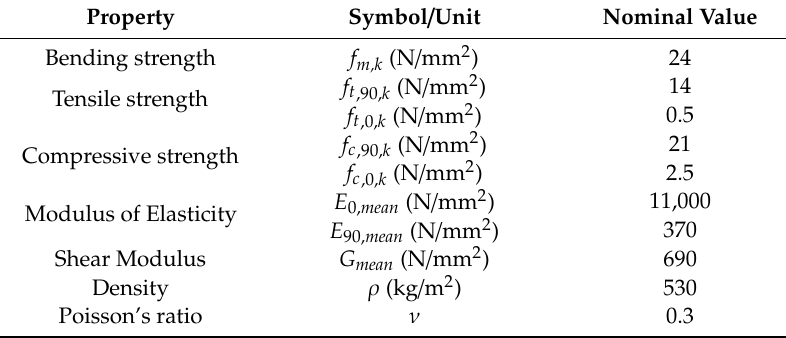
Table 1. Nominal mechanical properties of Scots Pine wood ( Pinus sylvestris L.), resistance class C24 according to